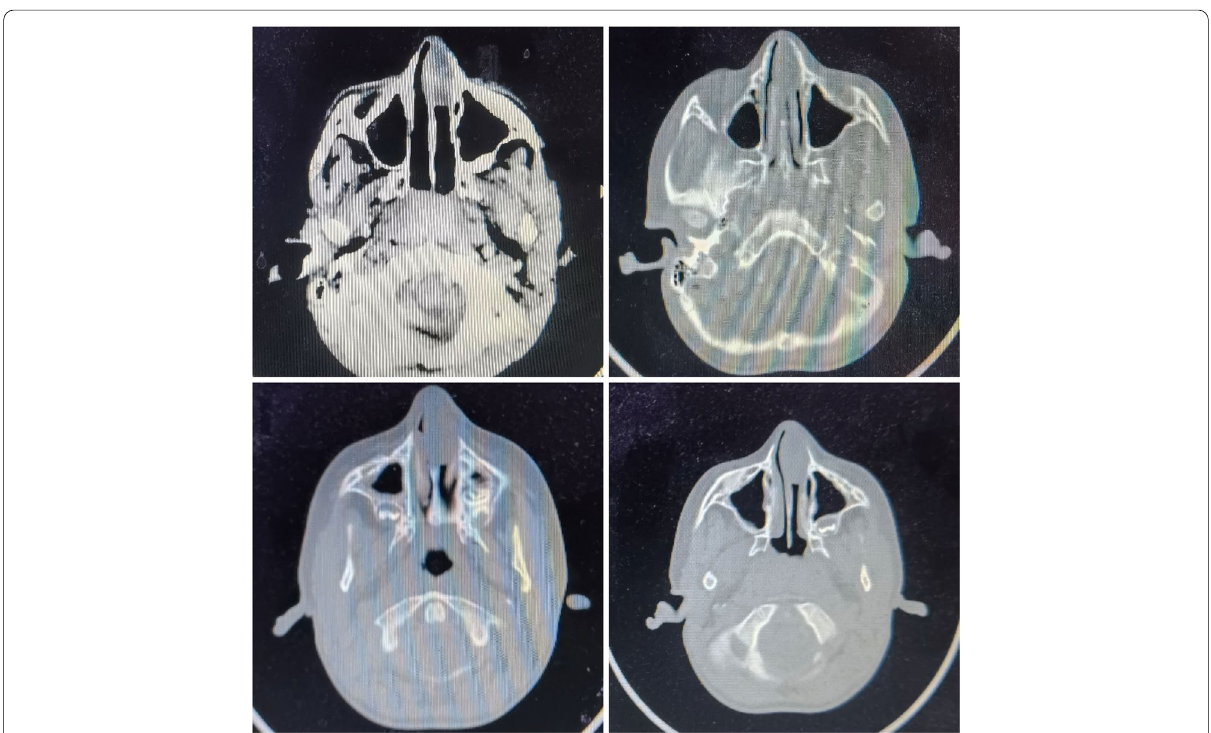
Fig. 1 A CT scan of the nose and paranasal sinuses. A soft tissue mass filling the anterior half of the left nasal fossa and deviating the anterior part of the septum to the right side. The mass was well circumscribed. Difficult to identify its origin. No extension into the nasopharynx or any paranasal sinuses and no bony erosions were